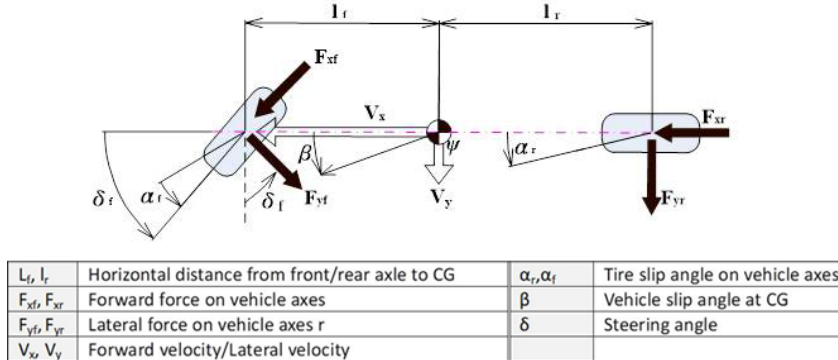
Figure 13. Simplified two-wheel steering